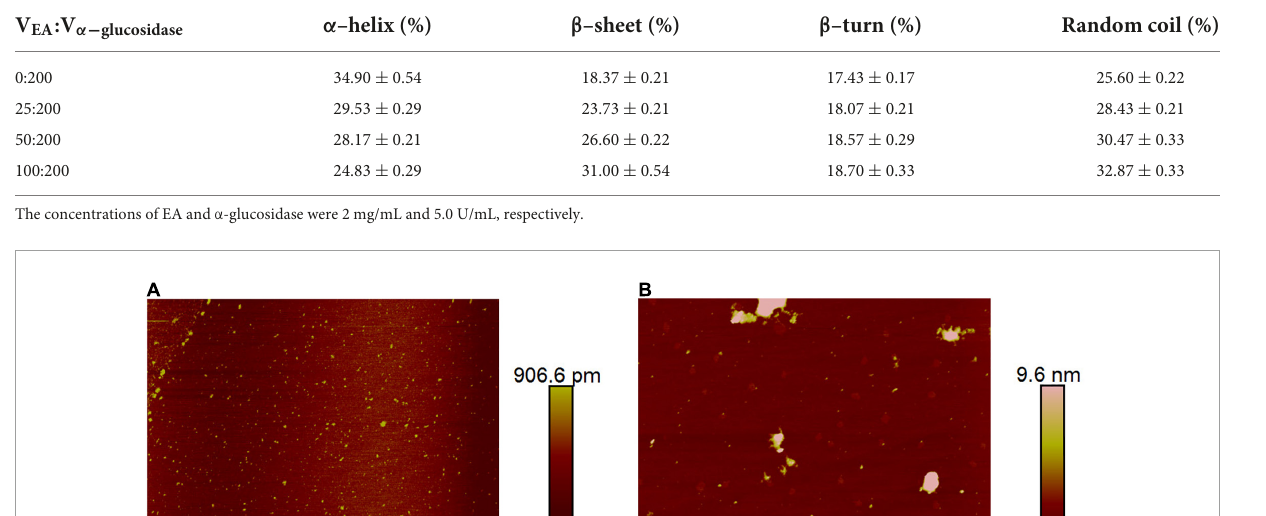
TABLE 3 The secondary structure contents of α -glucosidase that influenced by different contents of EA.